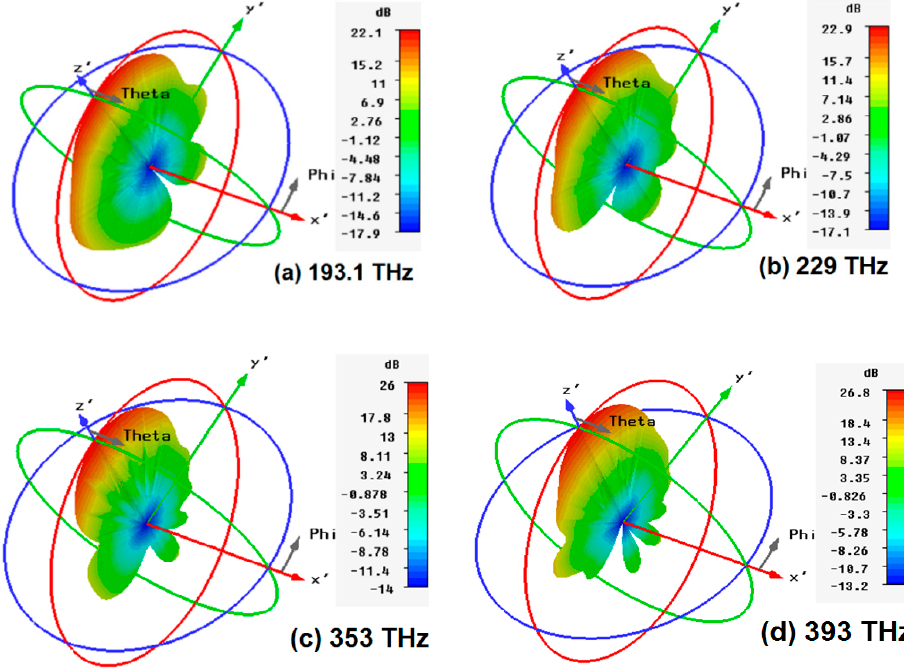
Figure 19. The 64 × 1 array 3D far field gain pattern at ( a ) 193 THz; ( b ) 229 THz; ( c ) 353 THz; ( d ) 390 THz. Table 3. Summary of the overall results of gain and directivity.